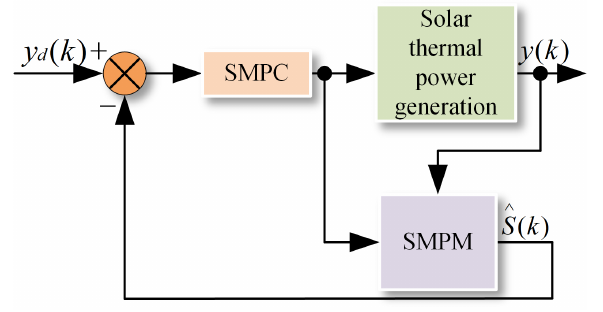
Fig. 1. The structure of the solar thermal power generation collector field sliding mode prediction